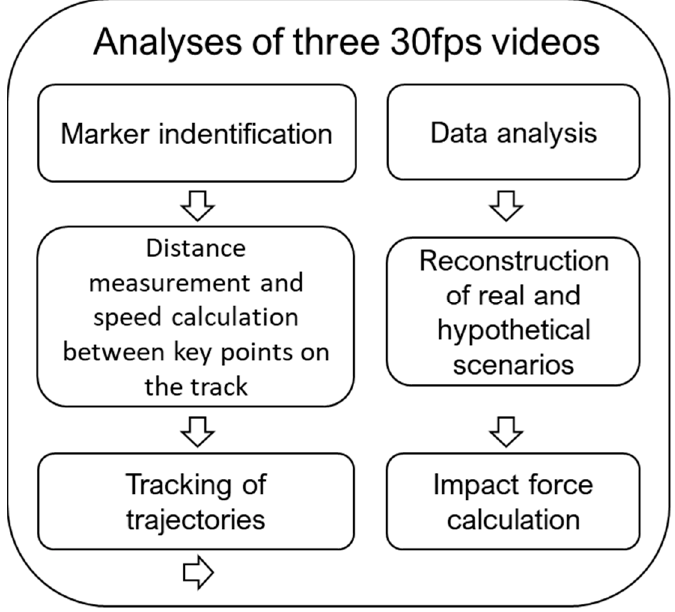
Figure 2. Chart showing the analytical procedures applied in the study.